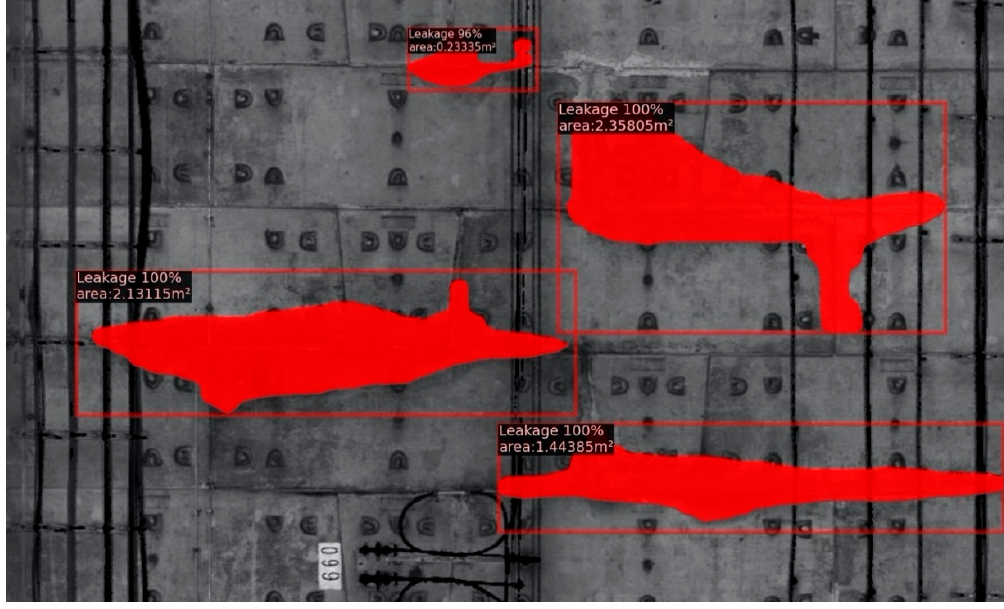
Figure 13. Water leakage evaluation in 2D.